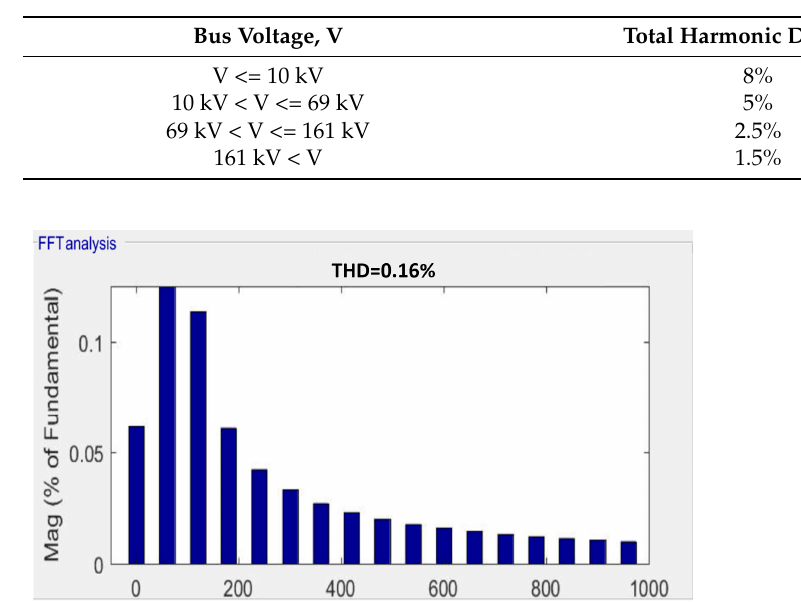
Figure 8. FFT (Fast Fourier Transform) analysis of the actual bus system and first two